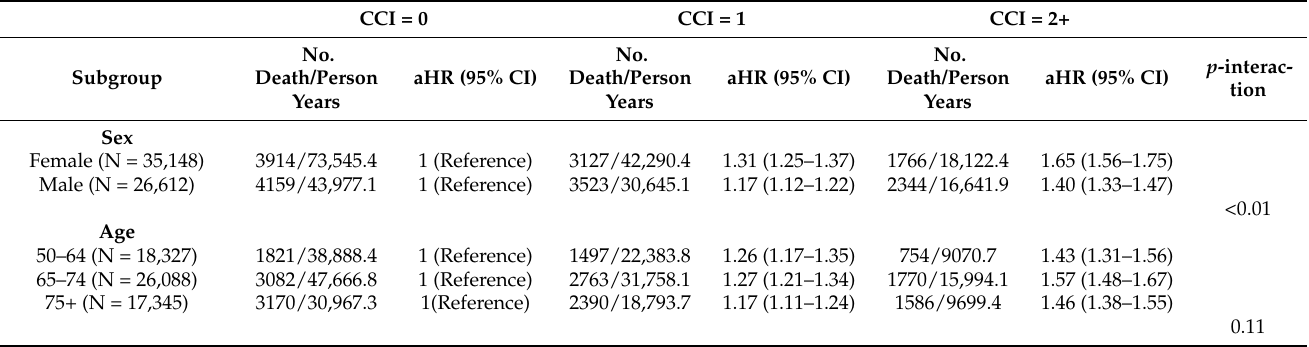
Table 3. Subgroup analysis for the association between CCI and risk of all-cause mortality by selected